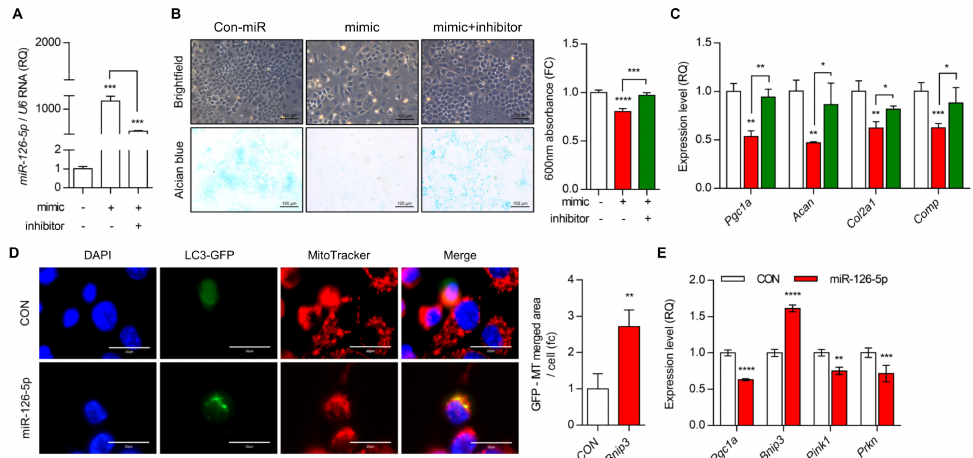
Figure 4. miR-126-5p dysregulates the homeostasis of cartilage matrix. ( A ) Efficiency of miR-126-5p mimic and inhibitor was confirmed by real-time PCR using iMACs. Scramble-miR was used as control (Con-miR). ( B ) iMACs seeded with the density of 1 × 10 4 /24 well culture dish were transfected with miR-126-5p mimic or inhibitor, stained with Alcian blue (left panel) and quantified based on absorbance at 600 nm (right panel). The results shown are representative of at least three independent experiments. ( C ) The transcription level of Pgc1a , Acan , Col2a1 , and Comp were analyzed using qRT-PCR ( n = 3). ( D ) Representative images of LC3-GFP and MitoTracker with the introduction of miR-126-5p mimic into iMACs ( n = 5; Scale bars, 20 µ m). Results are representative of at least five independent experiments. ( E ) Transcription level of Pgc1a , Bnip3 , Pink1 , and Prkn were analyzed using qRT-PCR ( n = 3). Values were expressed as means ± s.d. An unpaired